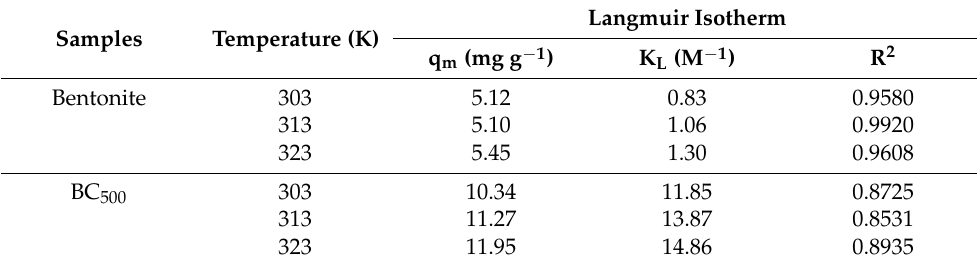
Table 10. Parameters for adsorption of diuron on bentonite and BC 500 .